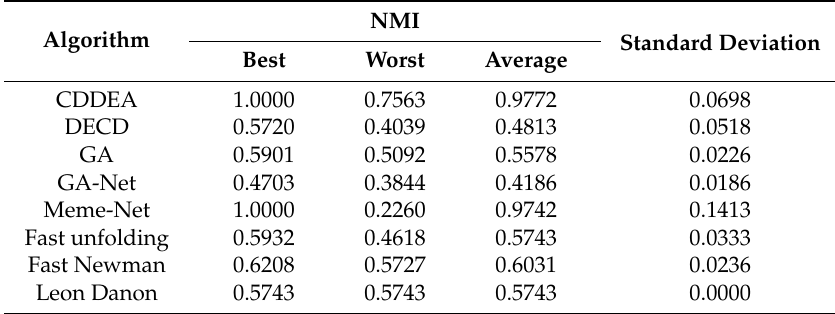
Table 3. NMI result obtained using eight algorithms on the bottlenose dolphins network.